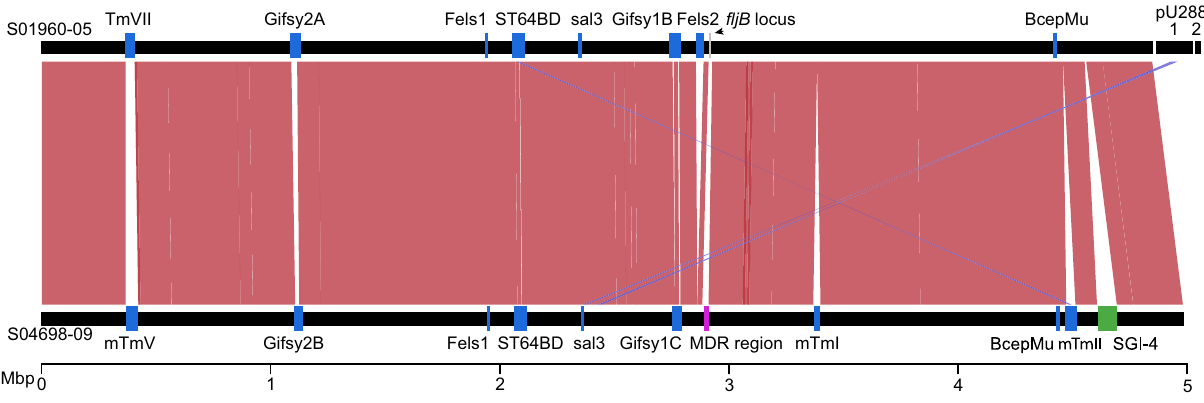
Fig. 3 Alignment of S . Typhimurium U288 strain S01960-05 and ST34 strain S04698-09 chromosome sequence. Genomes are indicated by horizontal black lines including pU288-1, pU288-2 and pU288-3. Scale bar indicates Mbp of nucleotide sequence. Shaded segments connecting the genomes indicate colinear (red) or reverse and complement (blue) regions with nucleotide sequence identity >90%. Notable features highlighted by coloured boxes and labels for prophage (blue), the SGI-4 integrative conjugative element (green), fl jB locus (grey) and a resistance region